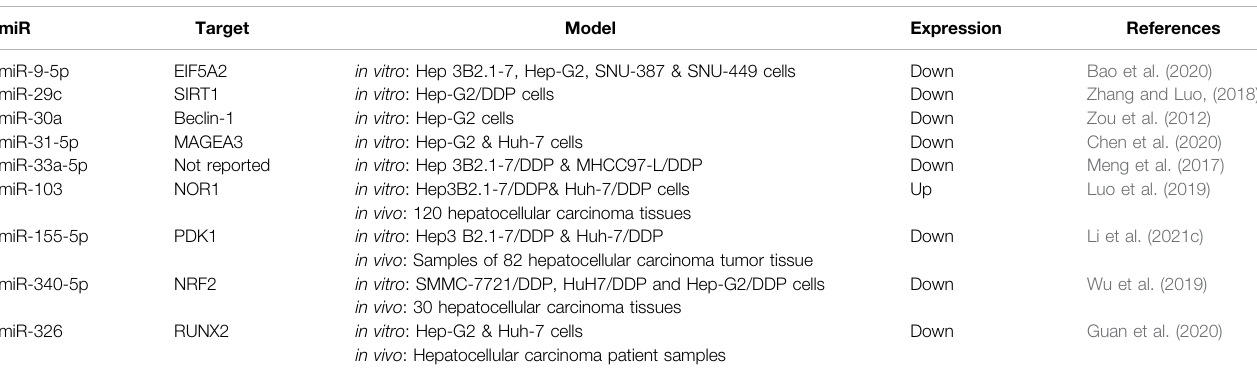
TABLE 2 | MicroRNAs involved in DDP-chemoresistance of liver